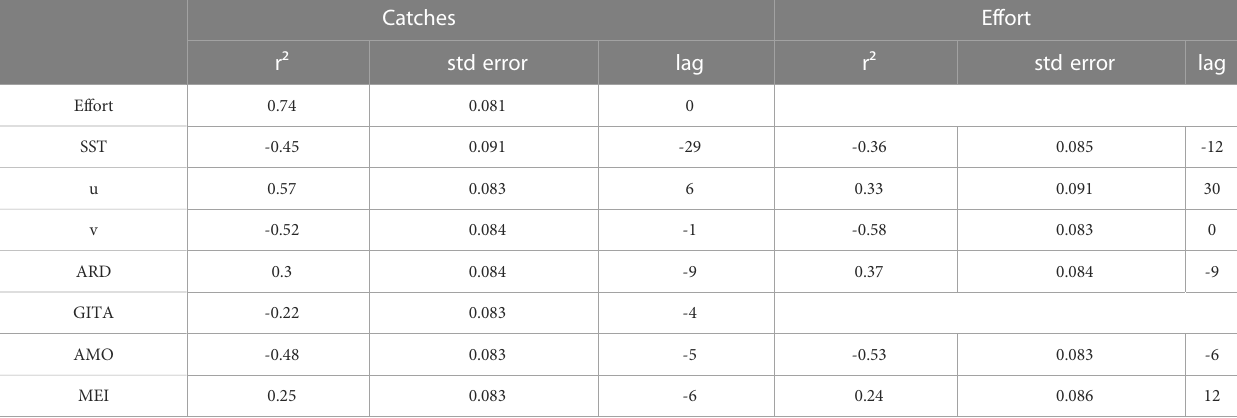
TABLE 1 Results of the cross correlation (r², standard error, and lag) between catches, fi shing effort, and the environmental variables: Sea Surface Temperature anomalies (SST), zonal and meridional wind components (u, v), Amazon River Discharge (ARD), the Atlantic Multidecadal Oscillation (AMO), Atlantic Ocean Inter-hemispheric Sea Surface Temperature Gradient Index (GITA), and Multivariate ENSO Index